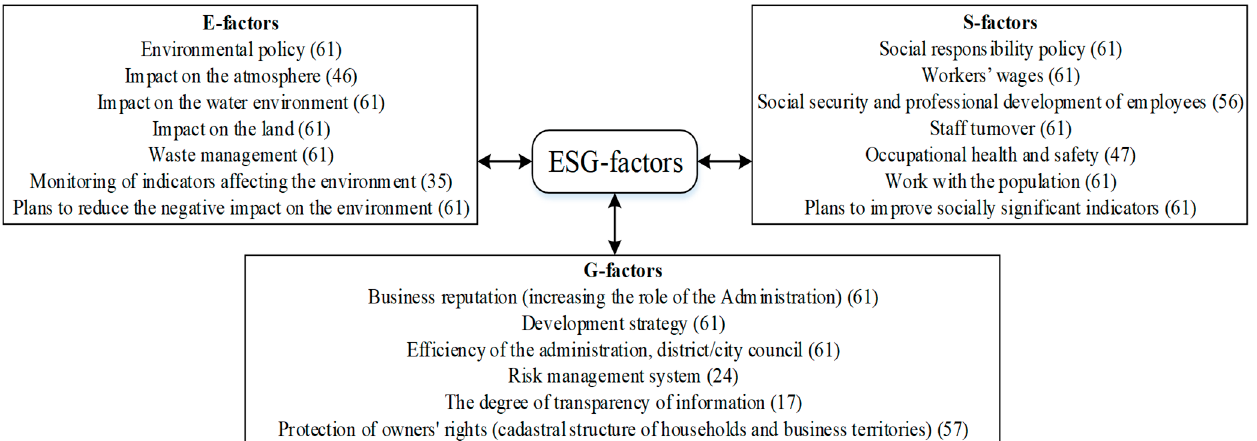
Figure 1. Implementation of separate principles for sustainable development.